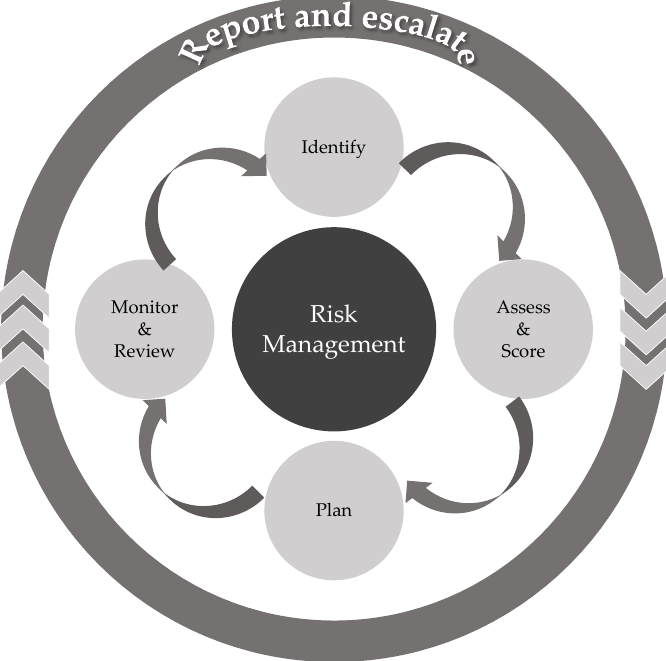
Figure 1. The risk management process (NHS England, 2020).